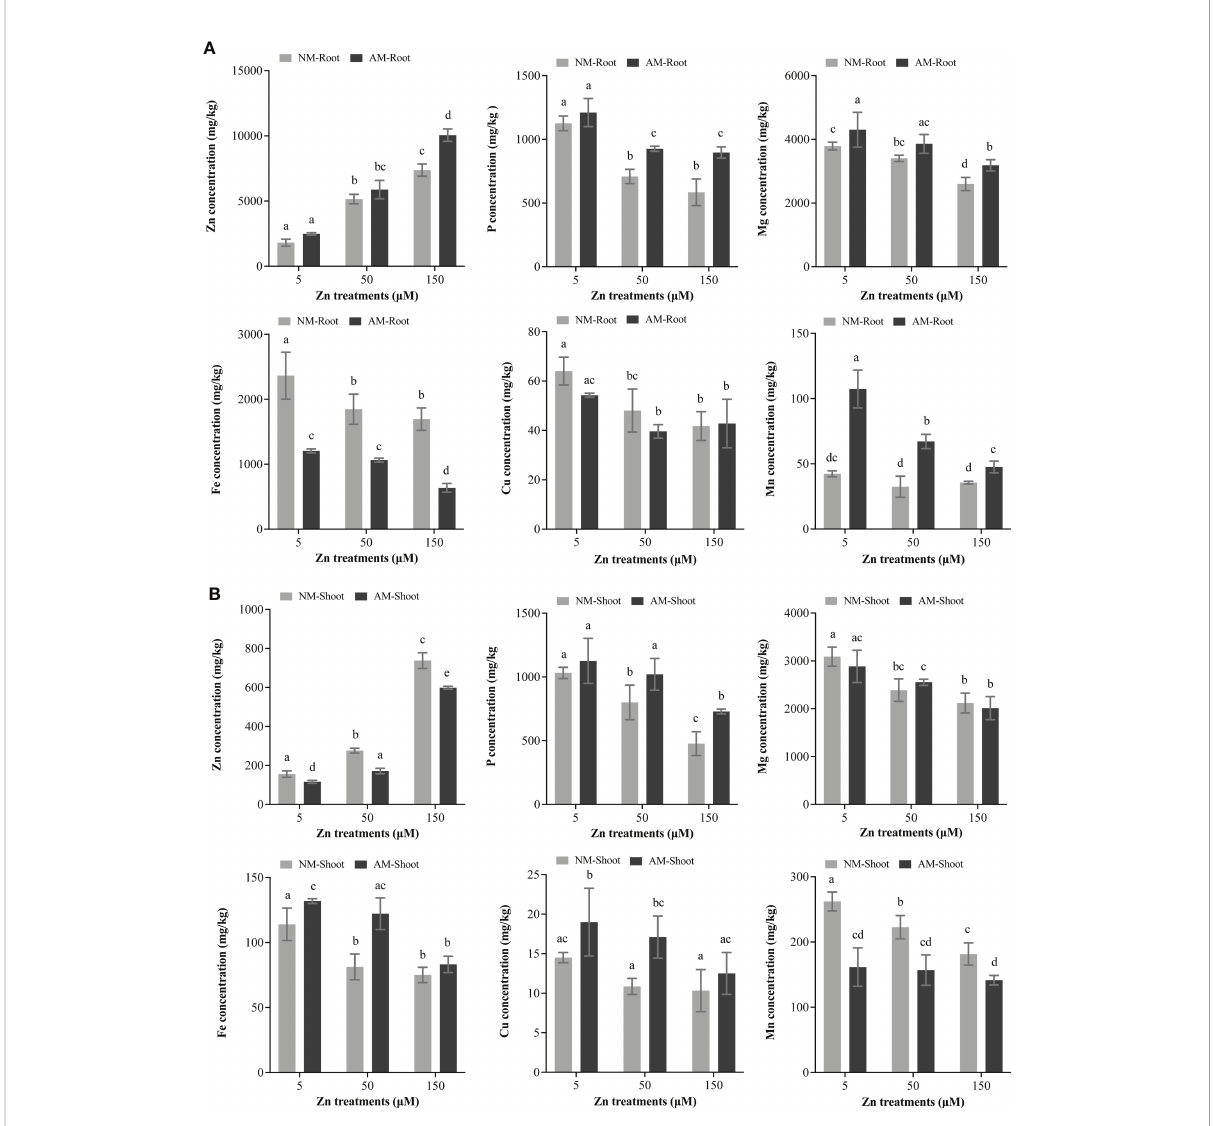
FIGURE 2 Total mineral element concentrations. The microelements (Zn, Fe, Cu, and Mn) and macroelements (P and Mg) of roots and shoots were analyzed by ICP-OES. NM, non-mycorrhizal plant; AM, mycorrhizal plant. (A) Total mineral concentration in root. (B) Total mineral concentration in shoot. Values were indicated as mean ± SE. Different letters above the bars indicated signi fi cant differences between treatments ( P <